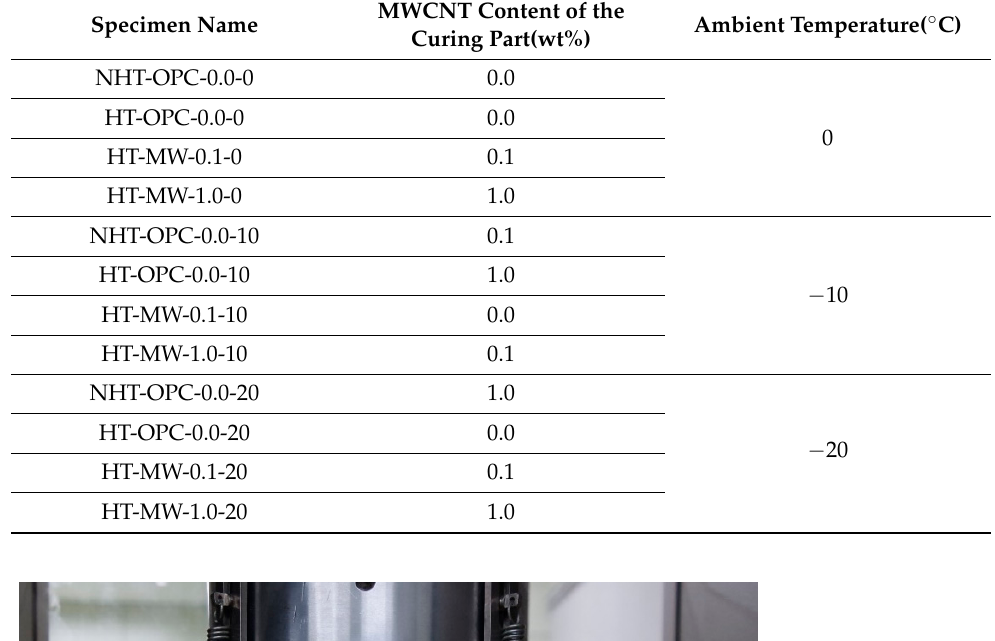
Table 1. Test parameters.